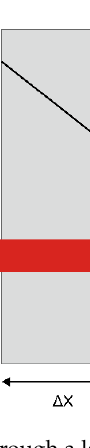
Figure 1. Heat conduction through a large plane of thickness Δ x and area A.